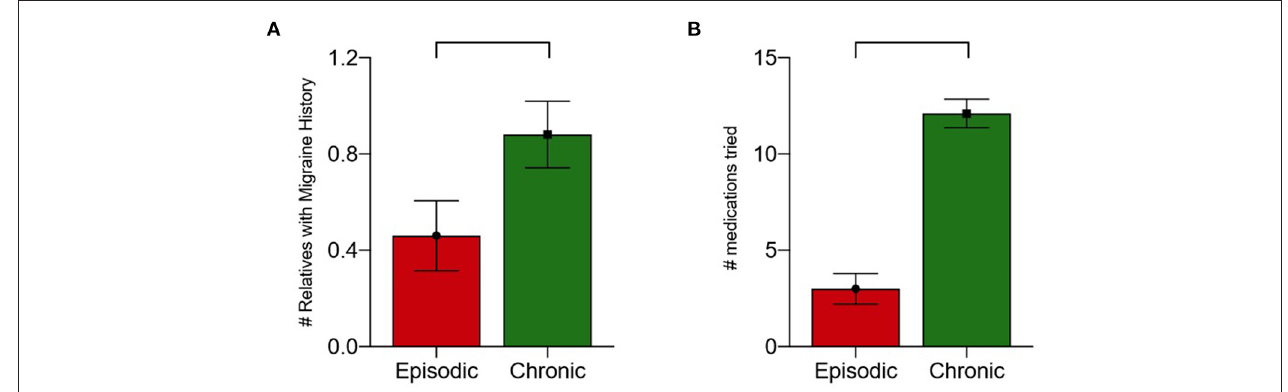
FIGURE 1 | (A) Number of first-degree relatives with migraine history by migraine type with correction for age and sex ( p = 0.035). (B) Number of medications tried by migraine type ( p < 0.001).